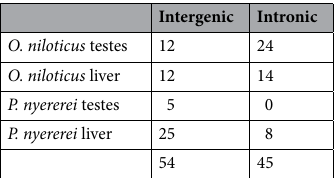
Identified in our study